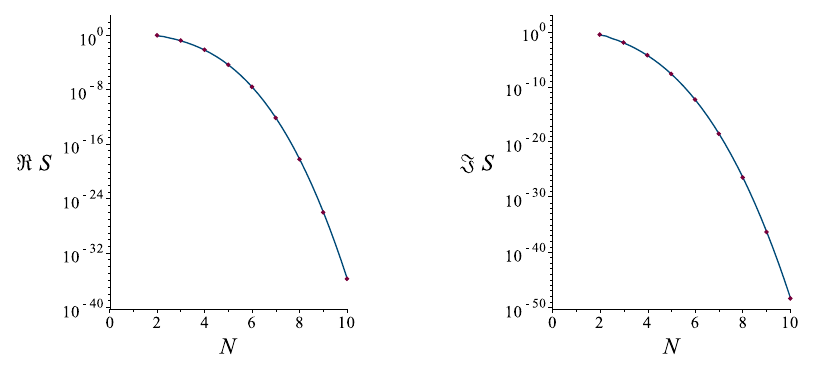
q 2 (cid:25) e Z N +1 (red dots) with the lateral g s